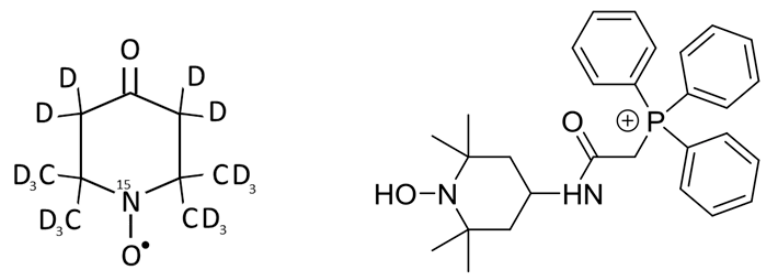
Figure 8. Chemical structures of 15 N-PDT used as a sensor for oximetry ( left ) and Mito-TEMPO-H used as a sensor for mitochondrial superoxide production.